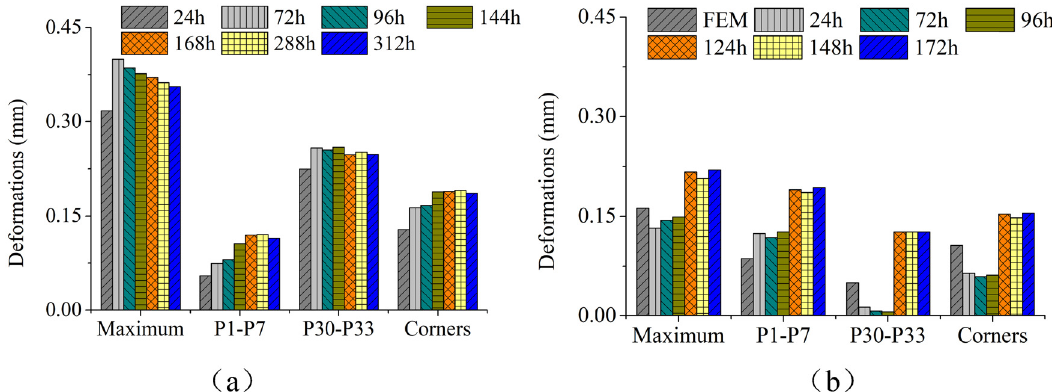
Figure 12: Comparison of deformation vary with time: ( a ) Specimen A and ( b )